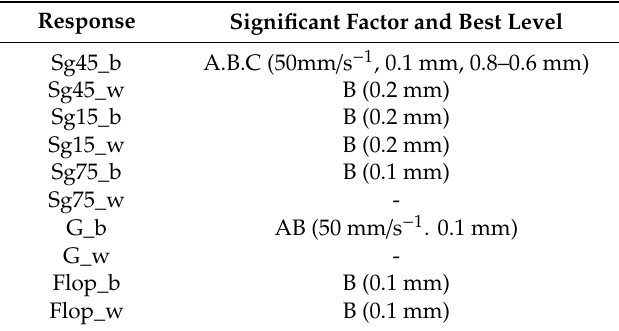
Table 7. The DoE analysis summary of the ABS samples.